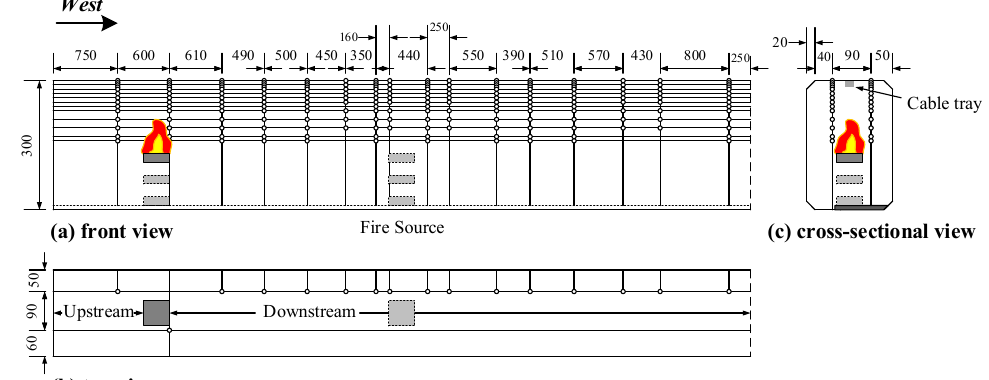
Figure 5. Schematic diagram of the full-scale test rig (dimensions in cm).